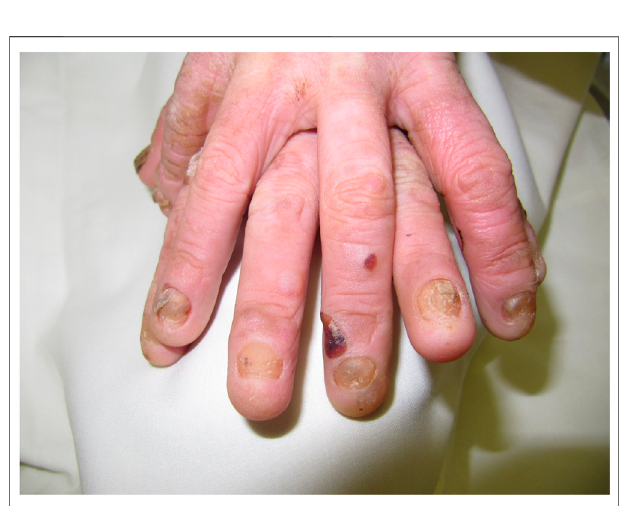
FIGURE 3 | Clinical presentation of junctional epidermolysis bullosa.